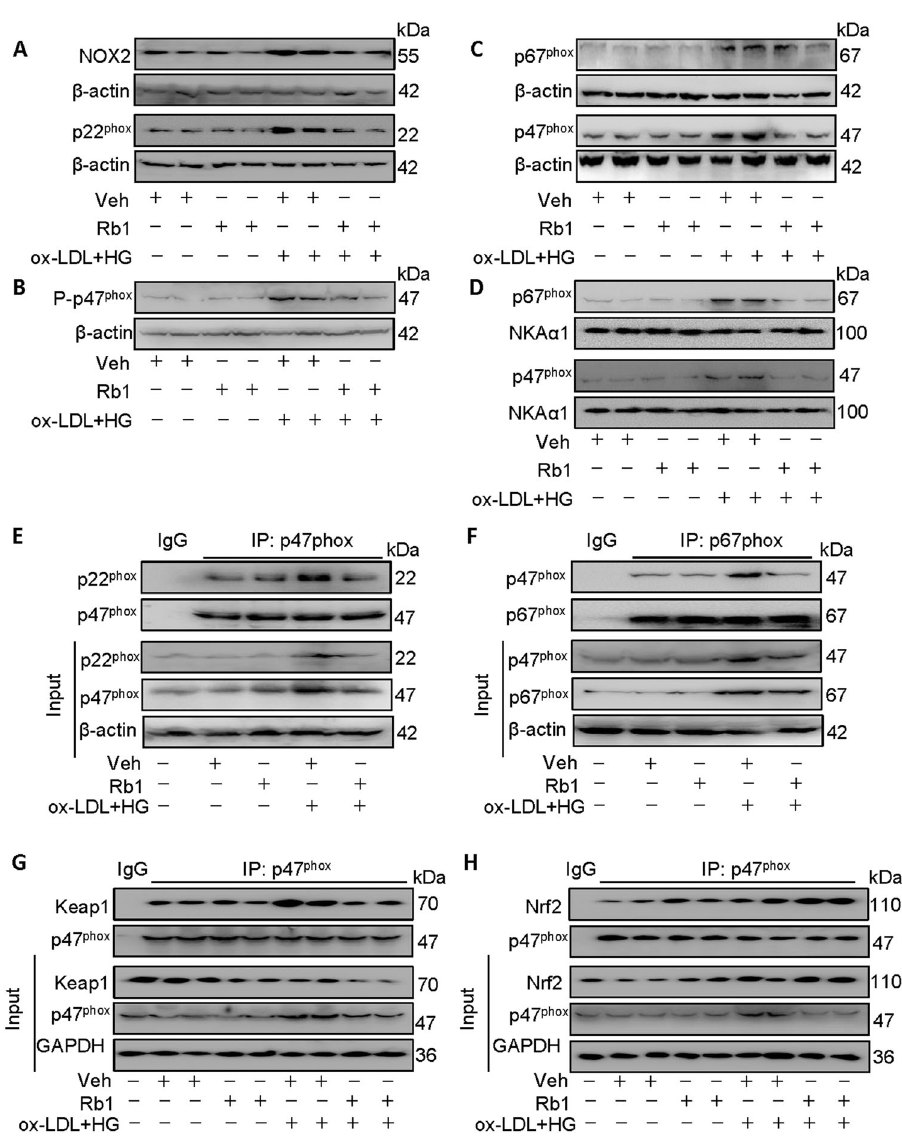
p67 phox . D Representative blots of membrane p47 phox and p67 phox . E Cell lysates were immunoprecipitated with an anti-IgG or an anti-p47 phox antibody, then blotted with an anti-p22 phox antibody. F Cell lysates were immunoprecipitated with an anti-IgG or an anti-p67 phox antibody, then blotted with an anti-p47 phox antibody. G Cell lysates were immunoprecipitated with an anti-IgG or an anti-p47 phox antibody, then blotted with an anti-Keap1 antibody. H Cell lysates were immunoprecipitated with an anti-IgG or an anti-p47 phox antibody, then blotted with an